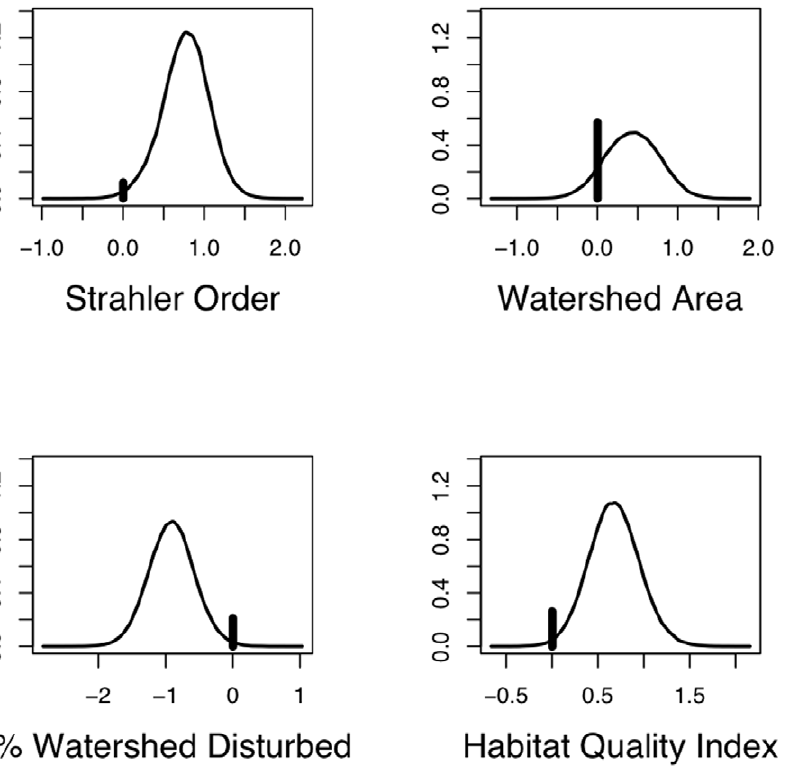
Figure 2. Marginal posterior density estimates for the top four PIP regression coefficients in the fish abundance analysis. Included are coefficients are: Strahler order ( b 1 ), Watershed area ( b 2 ), % watershed area disturbed by human use ( b 5 ), and habitat quality ( b 6 ). Vertical bars represent p ( b j ~ 0) and the density curve is a kernel estimate conditioned on b j = 0 .